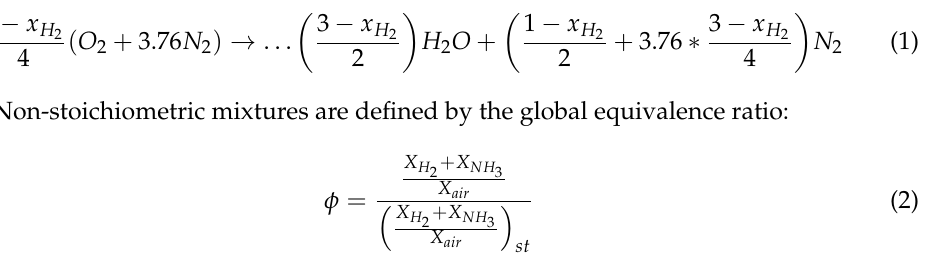
Table 3. Overview of the test conditions.